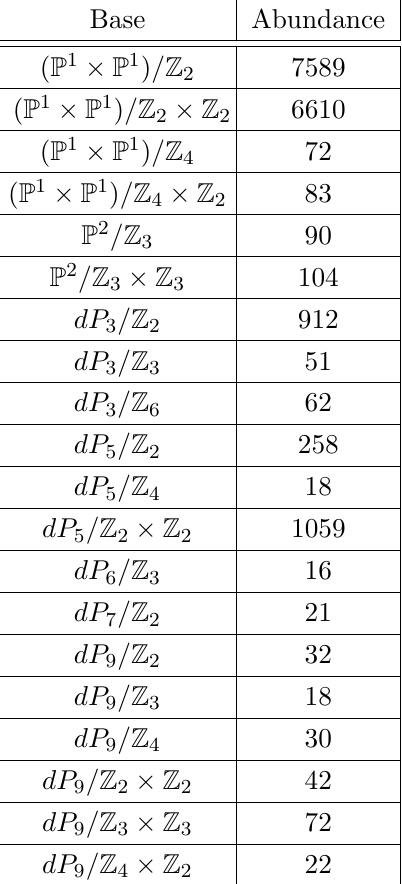
Table 2 . All of the base manifolds, ^ B of genus one (cid:12)brations, ^ (cid:25) : ^ X ! ^ B , which appear in the quotient CICY dataset being considered. Abundance refers to the number of di(cid:11)erent (cid:12)brations in which the associated base appears.